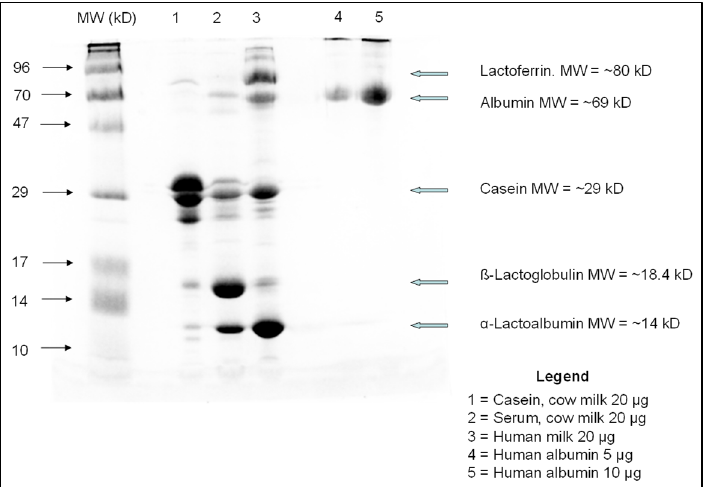
Figure A1. Polyacrylamide gel electrophoresis of human and cow milk samples. The quantities reported in the Legend are those of the protein amount loaded. The MW values reported on the first lane (from the left) are those of the reference MW standards used, those on the left the MW of the listed proteins. Abbreviations used: MW = molecular weight; kD = kiloDalton.